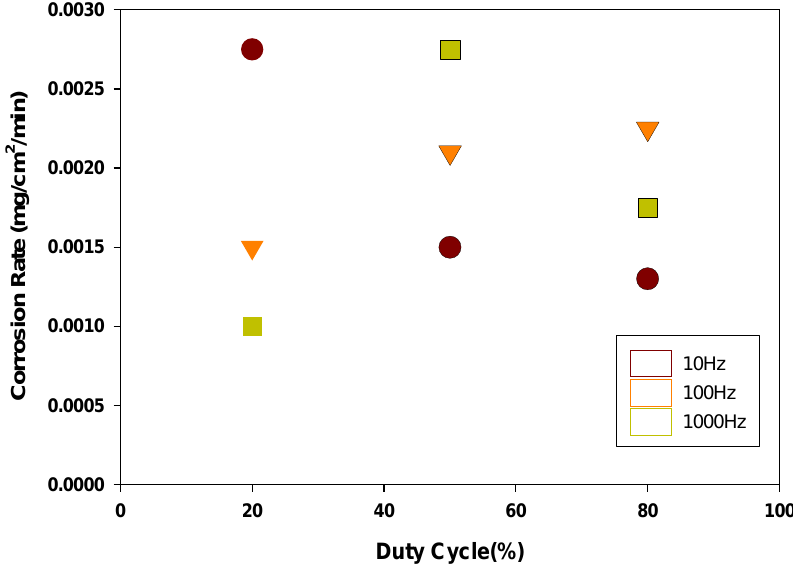
Figure 4. Effect of duty cycle on the corrosion rate of Au coated PCB substrates.